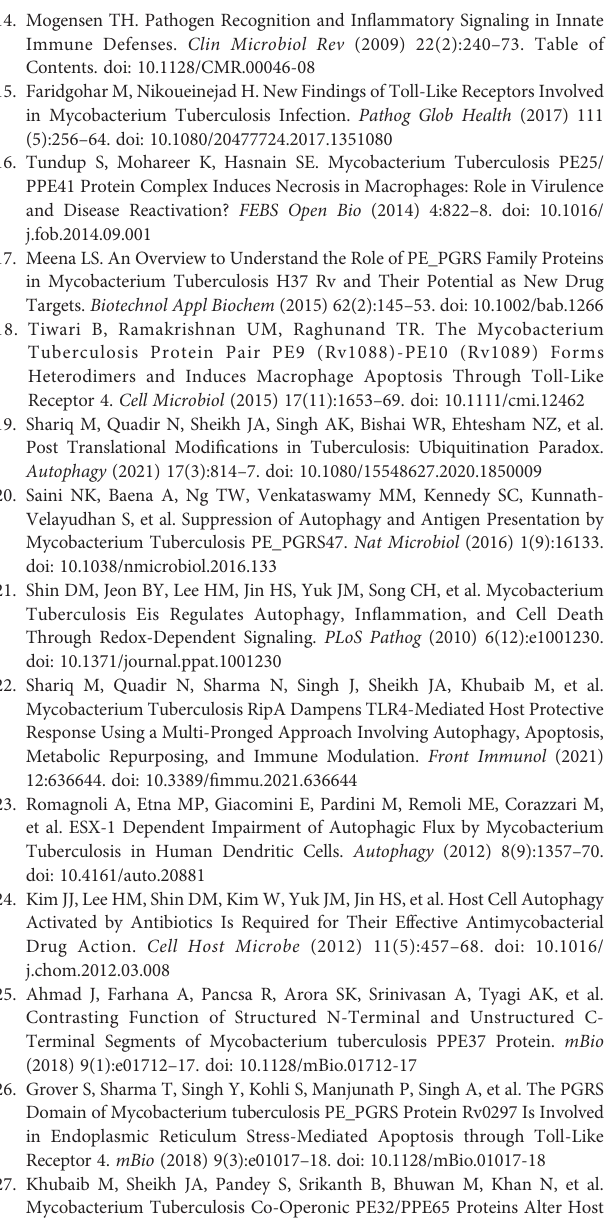
normalizes to b -actin. (D) Western blot showing the level of active Caspase 3 after treatment with various concentrations of PE6 for 24 hr, as shown in the fi gure. Untreated cells and HI PE6 treated cells were used as negative controls. Staurosporinewas usedasapositivecontrol. (E) FulllengthandcleavedCaspase3 were shown in Western blot. Macrophage cells were infected with recombinant M. smegmatis for 24 hr. The cell lysate was prepared and run in SDS-PAGE, and Western blotted using an anti-Caspase 3 antibody. Untreated and vector alone transformed cells were used as negative controls. b -actin was used as a loading control. (G) Western blots showing the levels of LC3BII and p62 at 24 hr post- infection with recombinant M. smegmatis containing pe6 and vector alone harboring cells. (H, I) Densitometric quantitation of LC3BII and p62 protein levels normalized to b -actin and represented as bar graphs. One-way ANOVA analyzed data with Tukey ’ s multiple comparison post-test. Data are representative of 2 independent experiments. *P<0.05 vs .